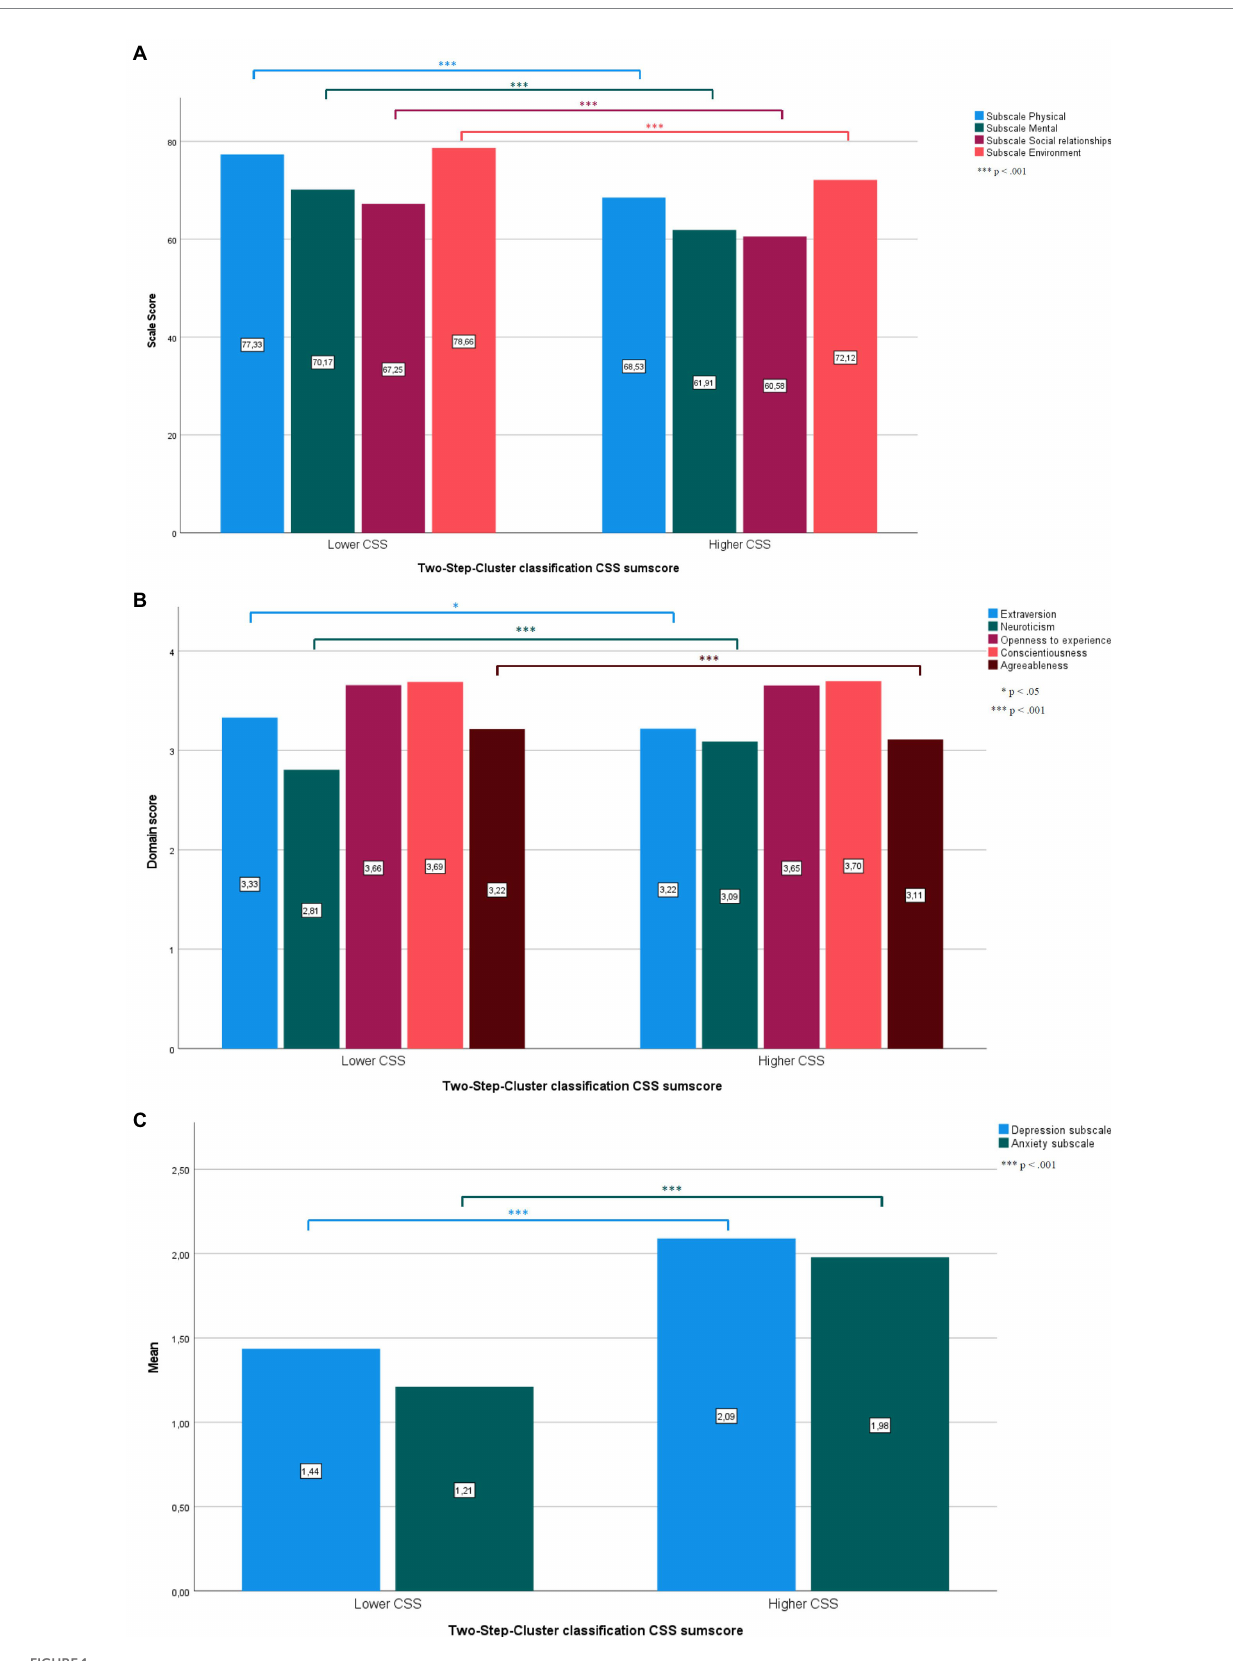
FIGURE 1 Significant and non-significant differences between the higher and lower CSS clusters in the WHOQoL-BREF (A) , BFI-10 (B) , and PHQ-4 (C) . Detailed statistical data are given in Table 3. (A) Scale values of the WHOQoL-BREF split by Cluster classification. (B) Domain Scores of the BFI-10 split by Cluster classification. (C) Mean values of the PHQ-4 split by Cluster